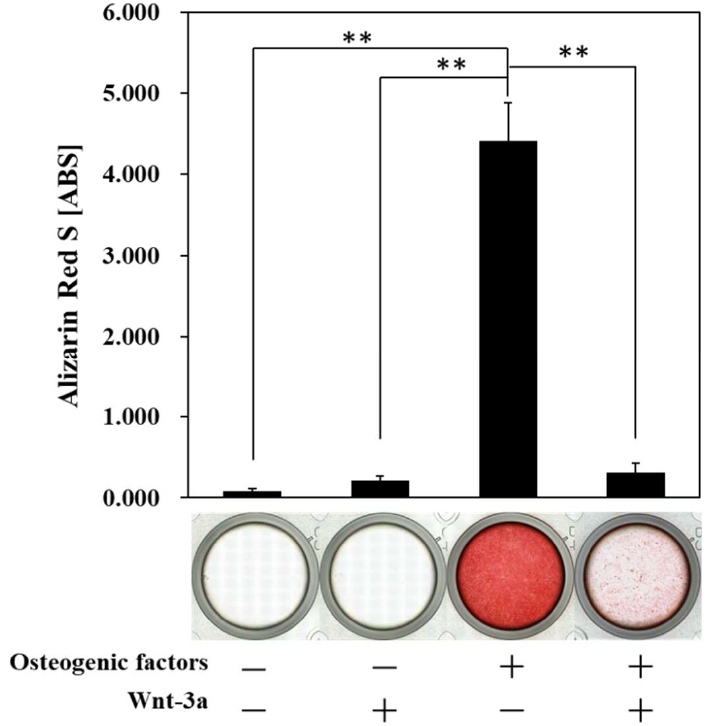
Figure 4. Alizarin red S staining after treatment with Wnt-3a. Cultivation of HPLFs in osteogenic medium resulted in the formation of calcified nodules in HPLFs, but Wnt-3a significantly inhibited this process. HPLFs were treated with osteoblast medium and Wnt-3a for 21 days. Data represent the means ± S.D. ** p < 0.01, (n = 3).